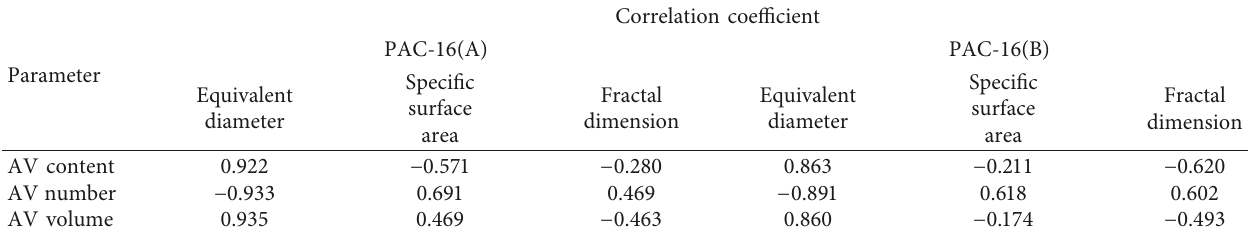
Table 6: Correlations between distributional and dimensional parameters for characterizing AV in PAC-16(A) and PAC-16(B) specimens.